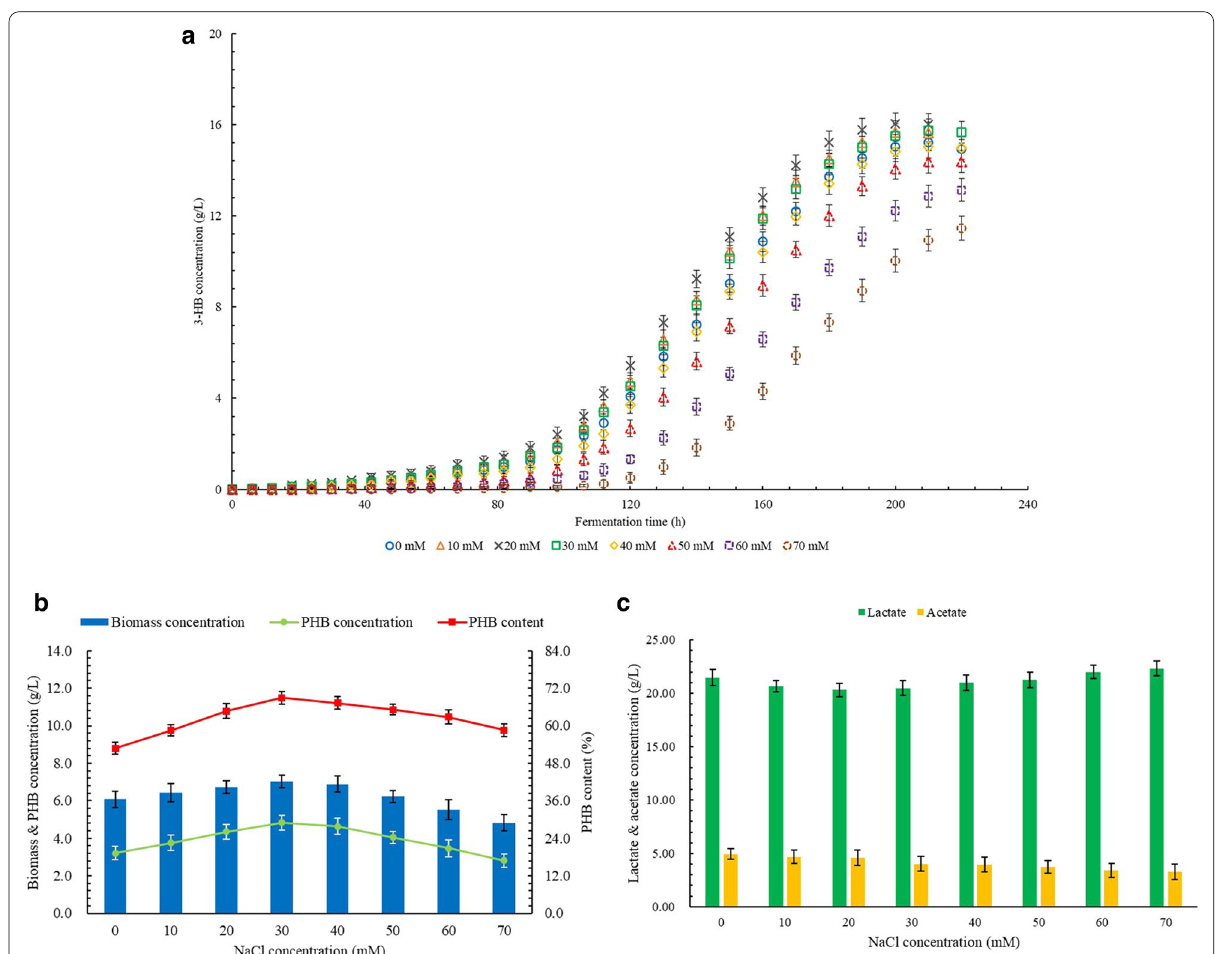
Fig. 1 a Effects of NaCl on the production of 3-HB. ( b ) Effects of NaCl on the production of PHB. ( c ) Effects of NaCl on the production of LA and AC